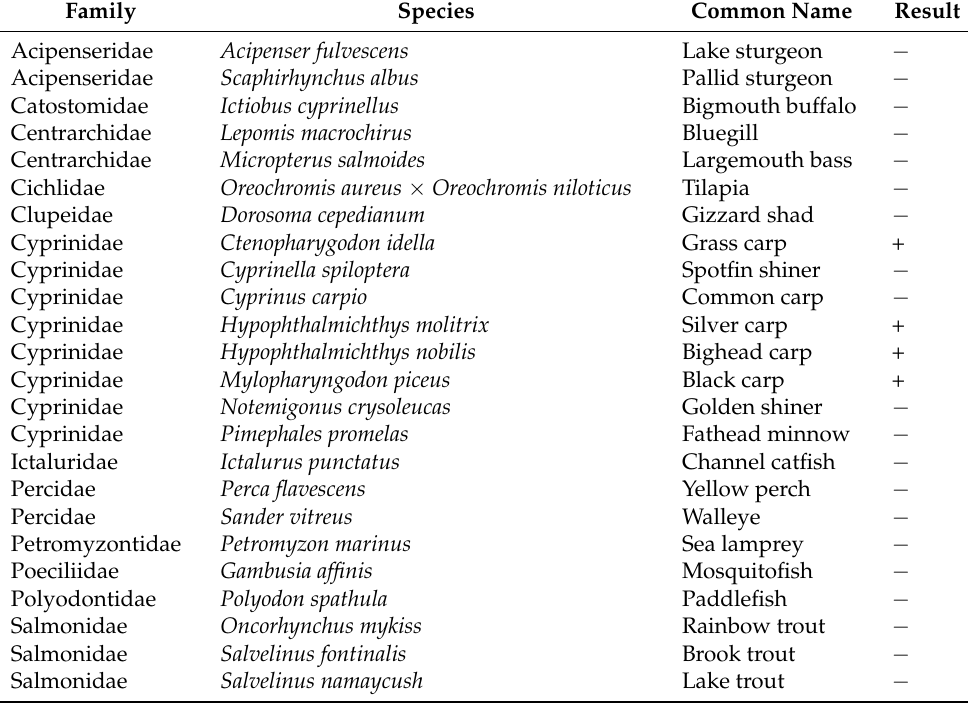
Table 2. Specificity testing against various fish species. Plus (+) indicates positive detection. Minus ( − ) indicates failed to produce detectable